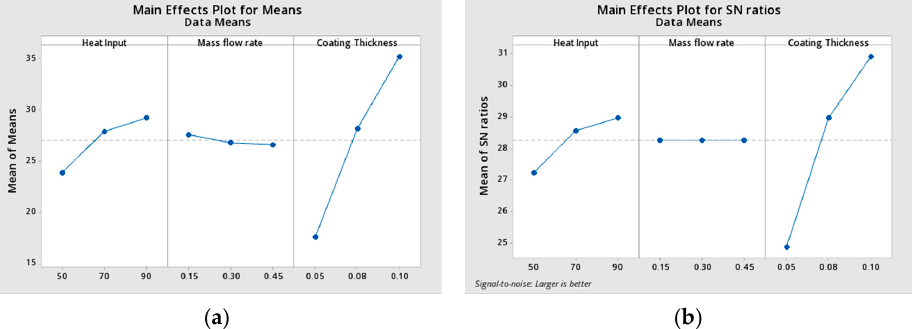
Figure 20. Taguchi Analysis for Effectiveness Versus Heat Input, Mass Flow Rate and Coating Thickness. ( a ) Main Effects Plot for Means; ( b ) Main Effects Plot for SN ratios